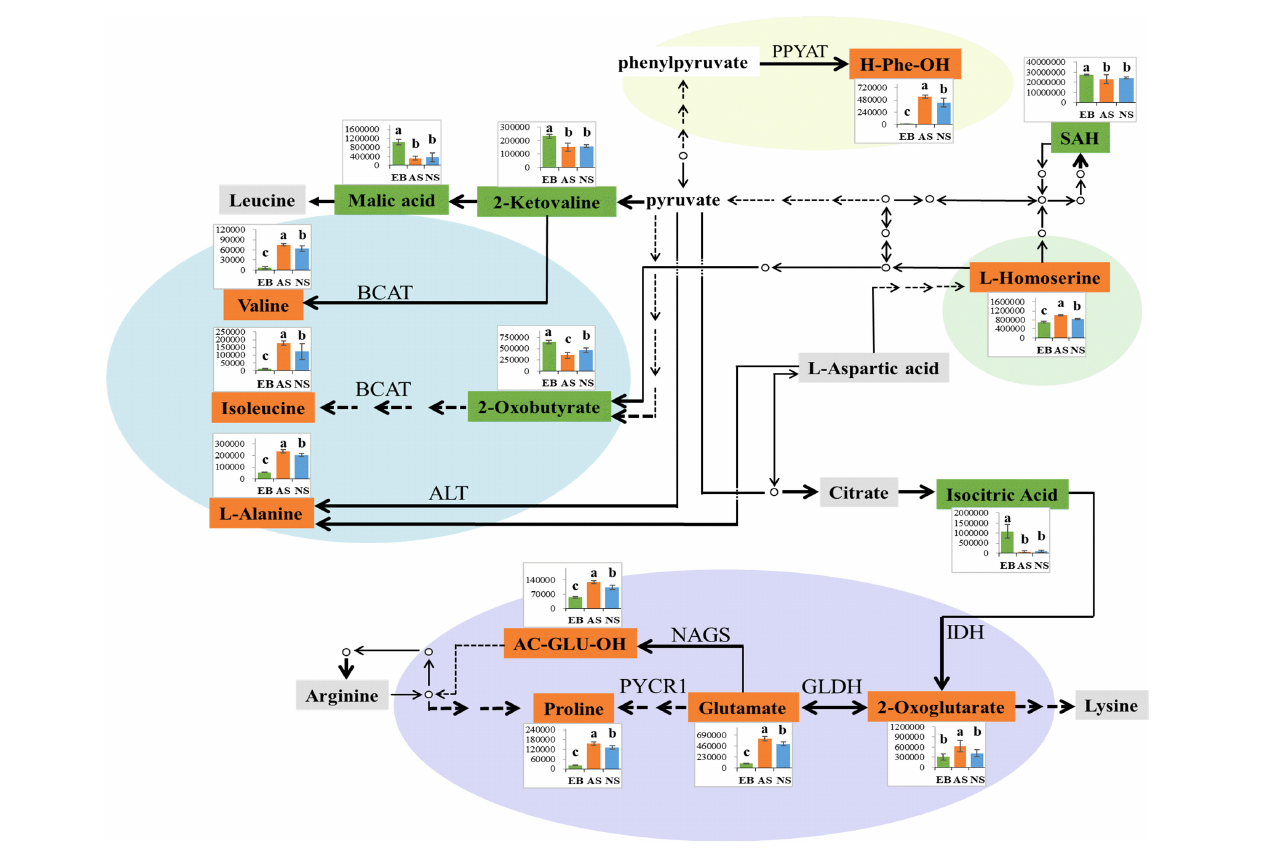
FIGURE10 Metabolic pathway visualization and relative metabolite abundance of Polygonati Rhizoma fermented by Lactiplantibacillus plantarum under aerobic and anaerobic conditions. EB, extracts of Polygonati Rhizoma before fermentation; AS, aerobic fermentation supernatants; NS, anaerobic fermentation supernatants; significant differences were identified by the ANOVA test ( p < 0.05); the compound displayed in green correlates with the highest content in EB; the compound displayed in orange correlates with the highest content in AS; the compound displayed in gray correlates with the highest content in both AS and NS compared with EB; PPYAT, phenylpyruvate aminotransferase; BCAT, branched-chain amino acid transaminase; NAGS, N-acetylglutamate synthase; IDH, isocitrate dehydrogenase; GLDH, glutamate dehydrogenase; PYCR1, Pyrroline-5-carboxylate reductase 1;